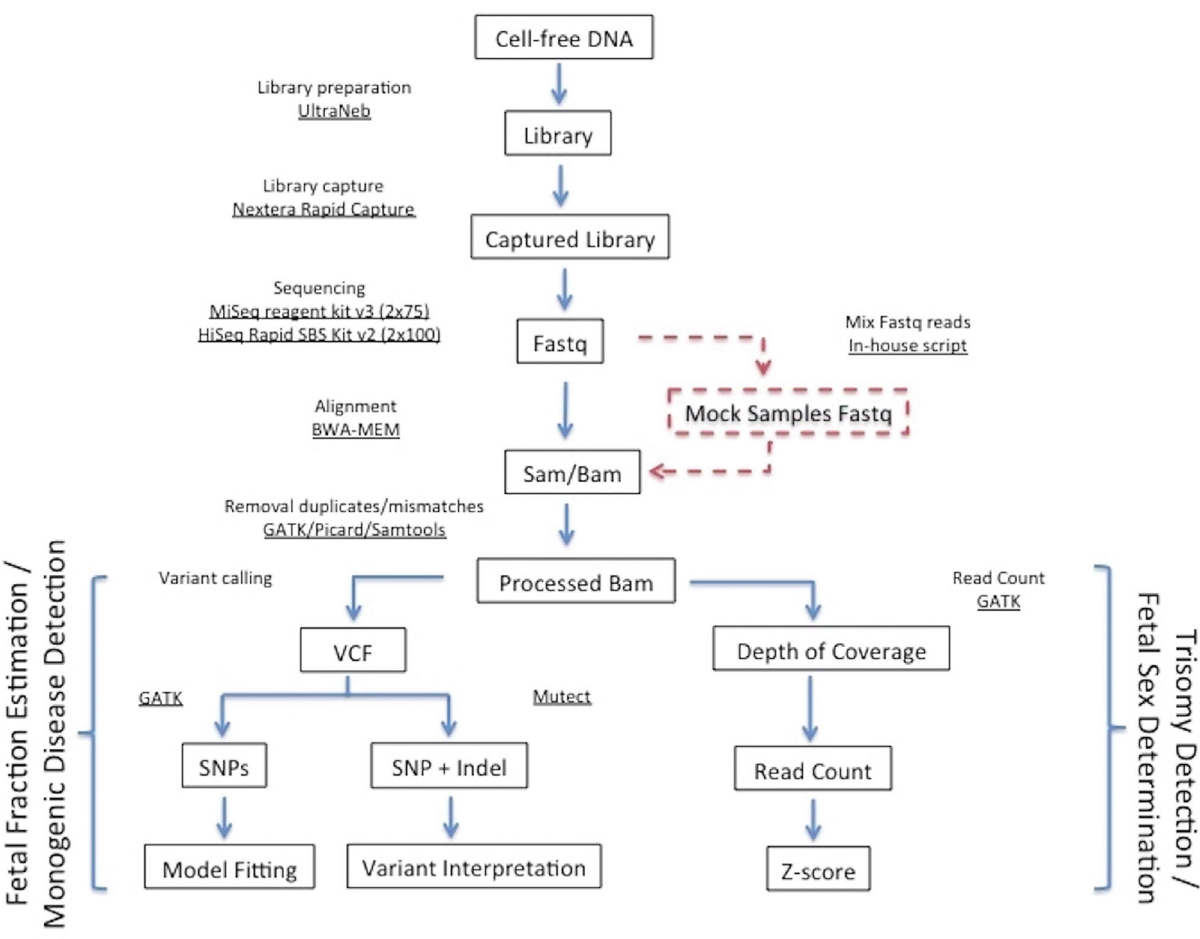
Table 1 - MAF given FF for different maternal/fetal genotype combina- tions in maternal plasma. Possibilities Origin Genotype Minor Allele Mean of B